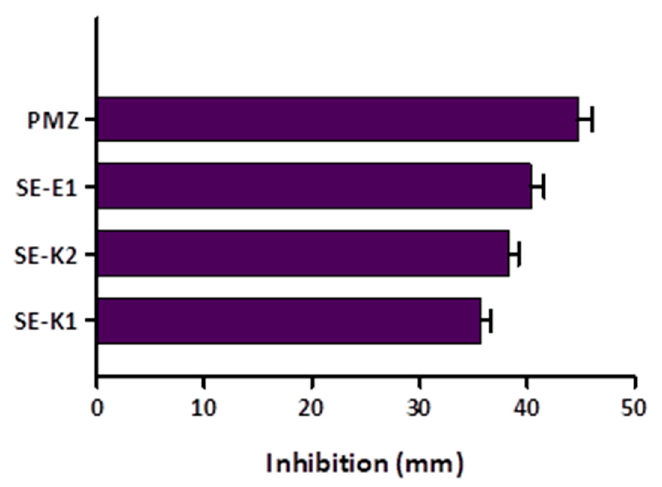
Figure 4. Quorum Sensing (QS) inhibition by selenocompounds. The QS-inhibition assay was performed using the parallel inoculation disk diffusion method. The ineffective compounds are not shown. Promethazine (PMZ) was used as a positive control.